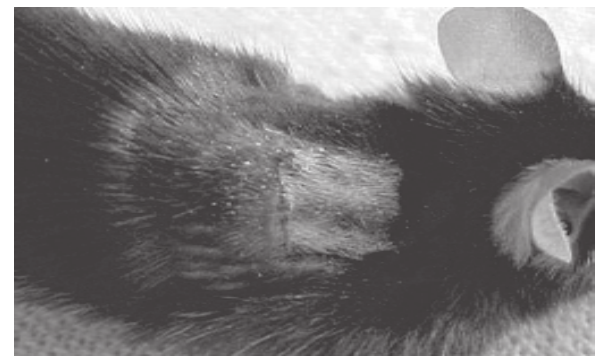
Fig. 2 - Transplante cutâneo: isoenxerto cutâneo em um camundongo da linhagem C57BL/6N, seis dias após o